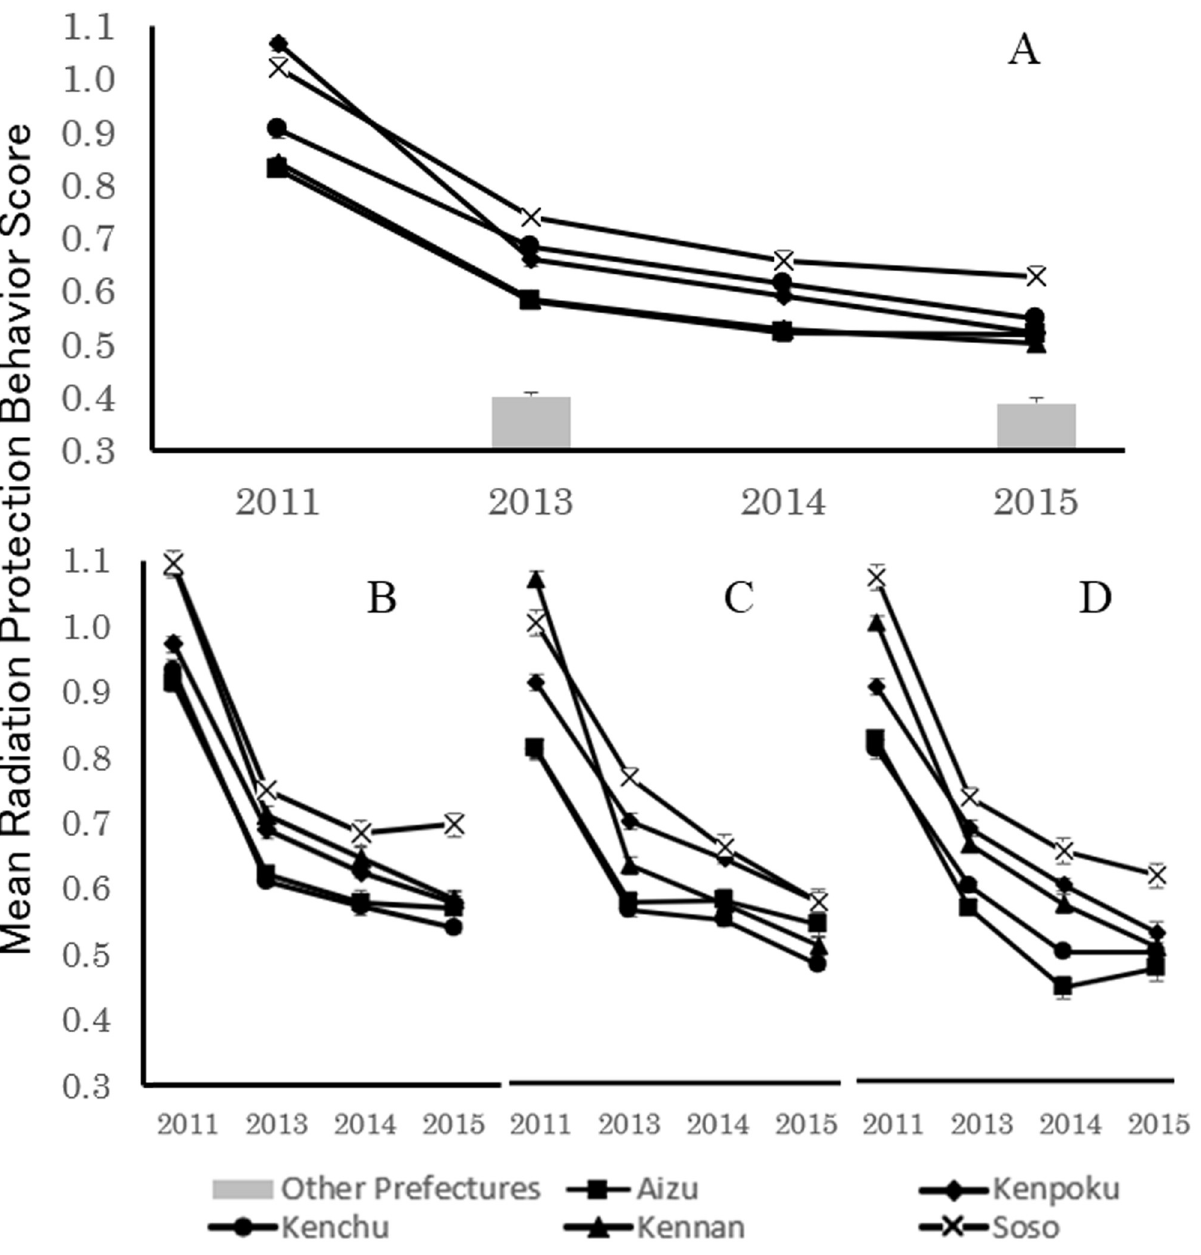
Fig 3. Transition over time in radiation protection behavior (Mean ± SE) of mothers residing in low-contamination regions. Panels B-D present data for mothers of four, 18, and 42-month-old children, respectively. In Panel A, the data for all mothers are combined.